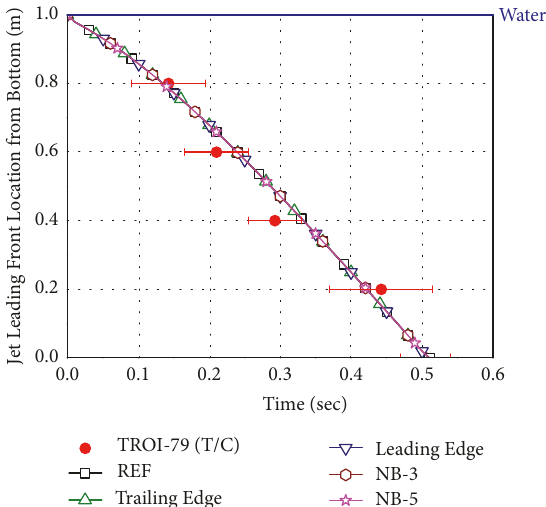
Figure 7: Locations of melt jet leading front in TROI experiment and TEXAS-V simulation for the submerged-RV condition with the results of sensitivity